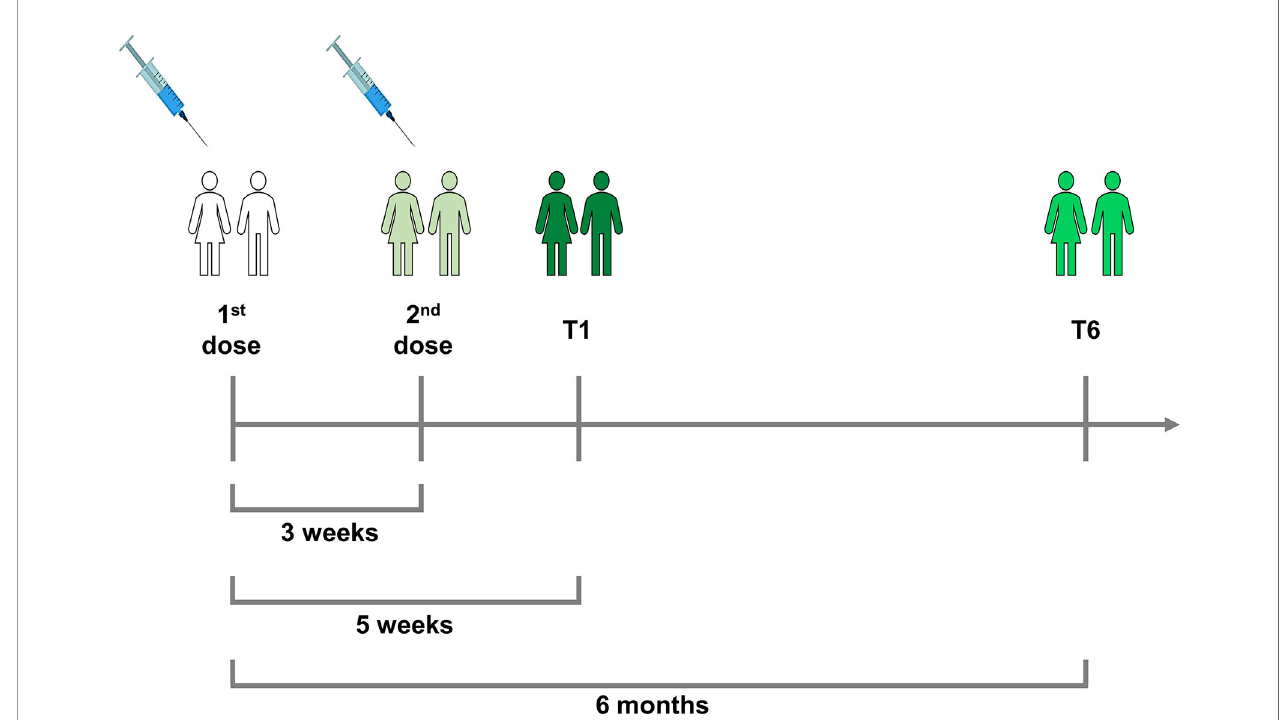
FIGURE 1 | Timeline of the two-dose schedule of BNT162b2 mRNA vaccine and of the enrollment of rheumatoid arthritis (RA) and health care worker (HCW) individuals. All subjects received the second vaccine dose after 3 weeks from the fi rst one. They were enrolled after 5 weeks (T1) and after 6 months from the fi rst dose of vaccine (T6). At T1 and T6, blood samples were collected from all the